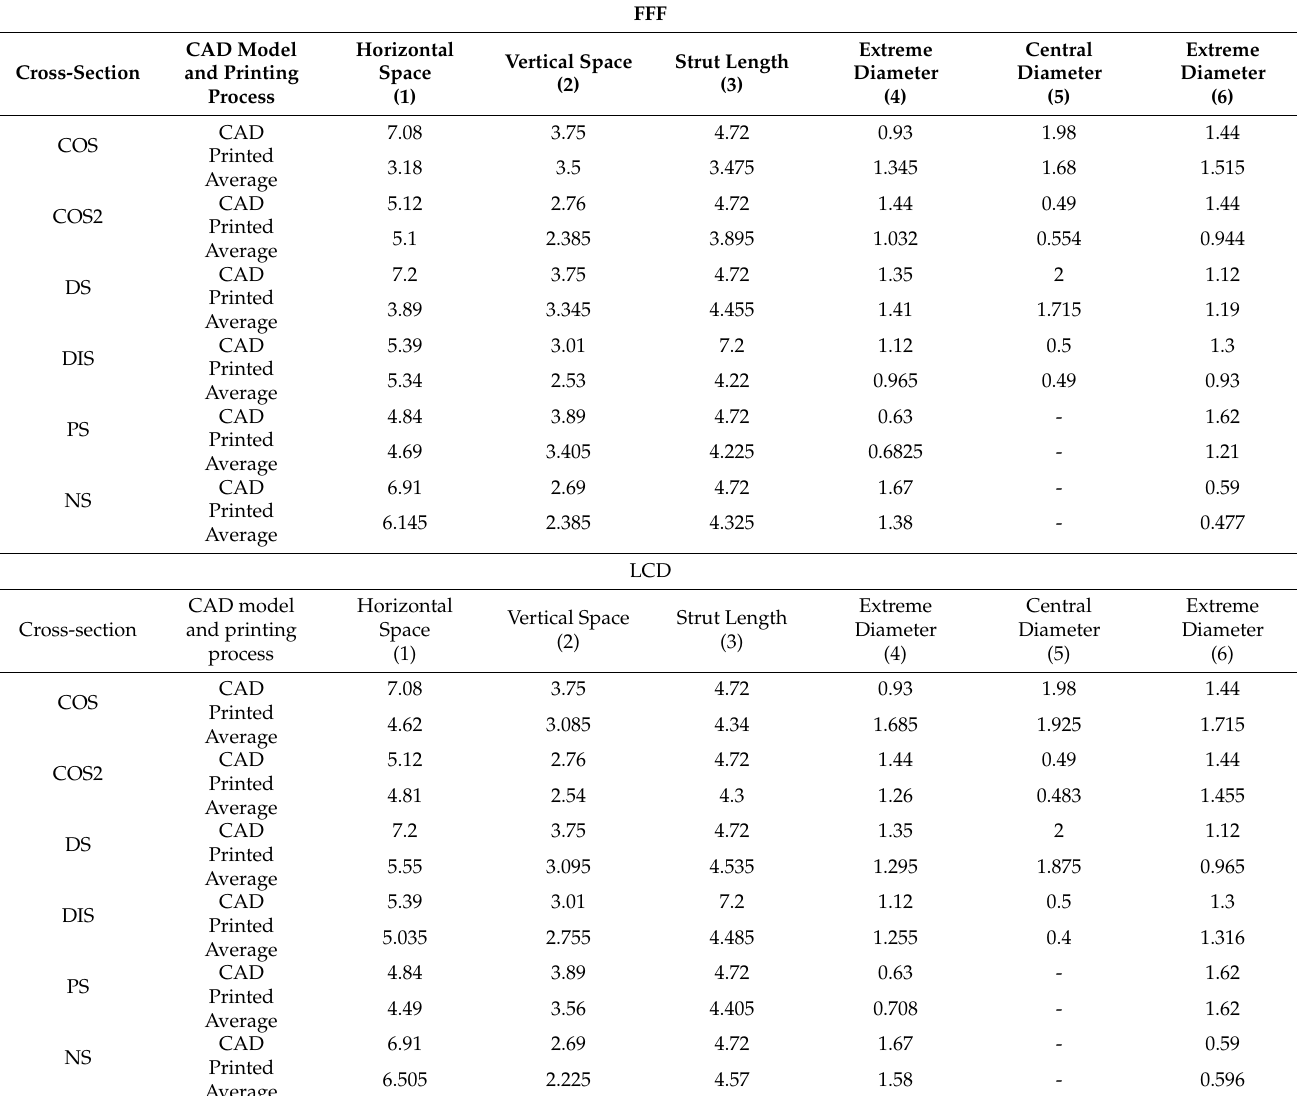
Table 2. Measurement of parameters in computational models and 3D printed